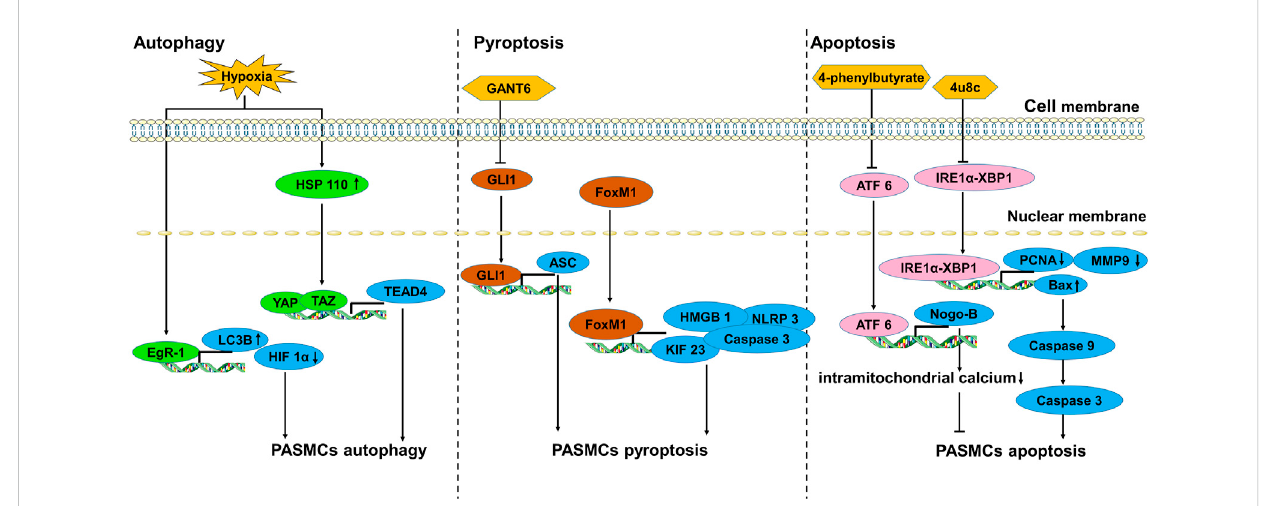
FIGURE 2 The transcription factors involved in the death of